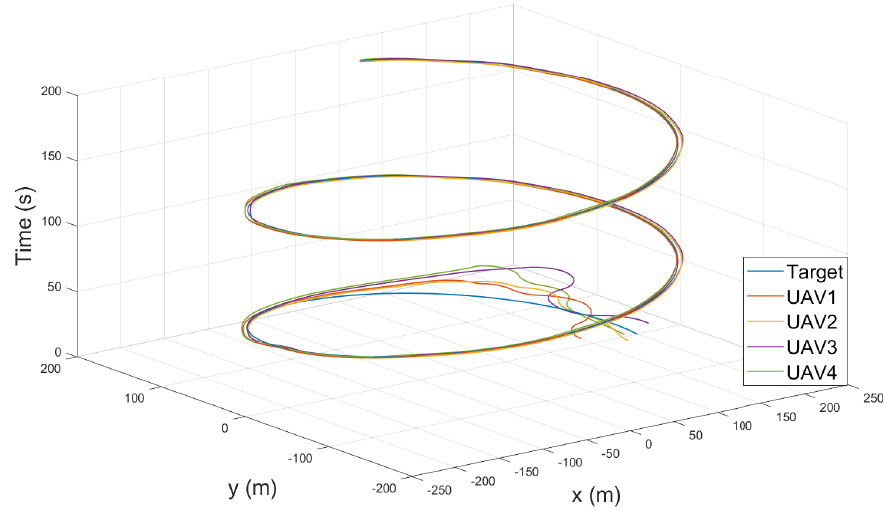
Figure 5. Trajectories of 4 UAVs and Target vehicle.